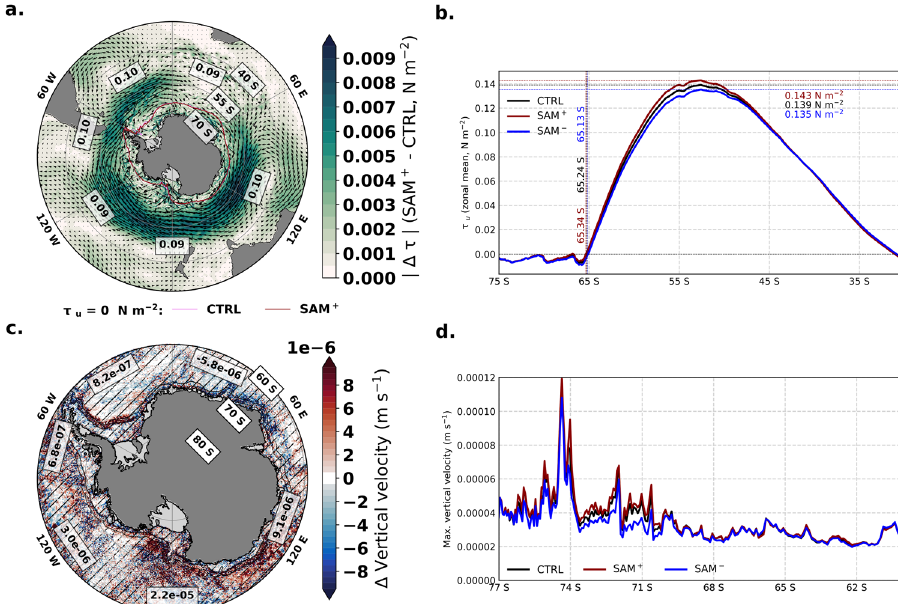
Fig. 5 Impact of SAM perturbations on the ocean. a Shadings: norm of the ocean surface stress difference between the CTRL and SAM + runs (i.e., k τ SAM þ (cid:2) τ CTRL k ); the two colored contours indicate zonal surface stress sign changes (i.e. τ u = 0) for both experiments; text boxes give each sector's average meridional shift in zonal stress direction change (in ∘ ; positive values indicate southward shift). b Circum-Antarctic zonal mean of the zonal surface stress in the CTRL, SAM + and SAM − runs. The SAM þ dyn zonal mean surface stress response is identical to the SAM + one, so it was not represented here. Colored vertical and horizontal lines, respectively, specify the latitudes of the southward shift of the mean zonal zero surface stress and the maximum westerly surface stress values. Here, “ surface stress ” is the total stress absorbed by the surface of the ocean, i.e. the combination of wind- and sea-ice- induced surface stresses weighted by the sea-ice concentration. c Map of the change in maximum vertical velocity (m s − 1 , representative of upwelling) between the SAM + run and the CTRL run. Hatching indicates non-signi fi cant changes at the 95% level and mean values (for the region located between the continental shelf break and 100 km north of the continental shelf break, delimited by the dotted lines) for each of the six regions shown in Fig. 1 are indicated inside white boxes. d Circum-Antarctic zonal mean maximum vertical velocity in the CTRL, SAM + and SAM − runs. The SAM þ dyn zonal mean vertical velocity response is similar to the SAM + one, so it was not shown here. All values are time-averaged over years 25 – 29.